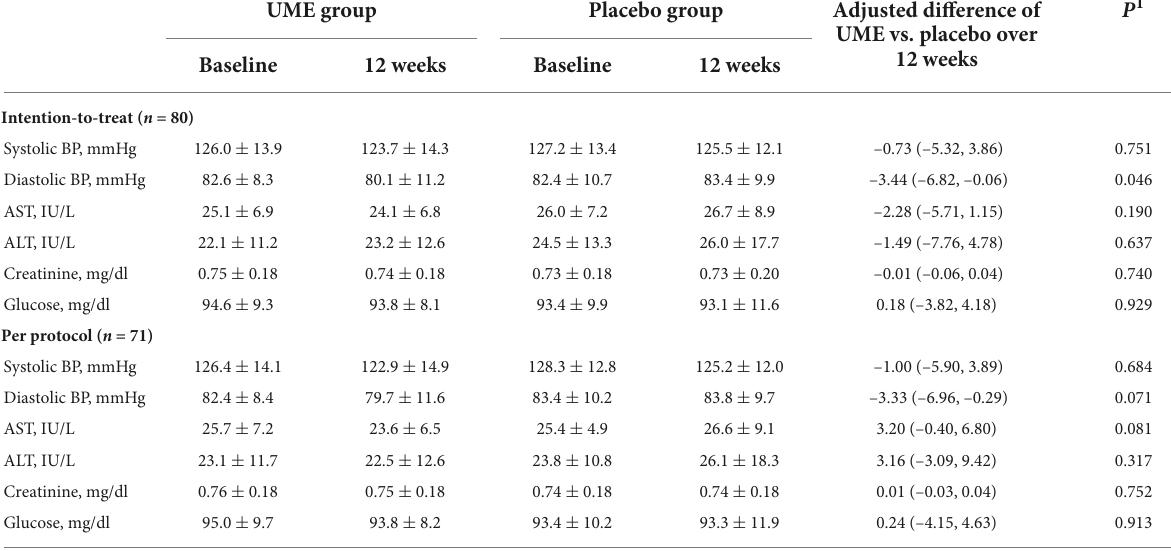
TABLE 5 Laboratory findings evaluating the adverse